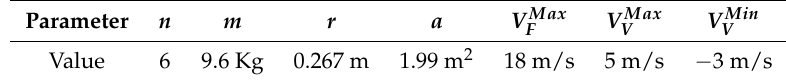
Table 3. Specific parameters for the UAV